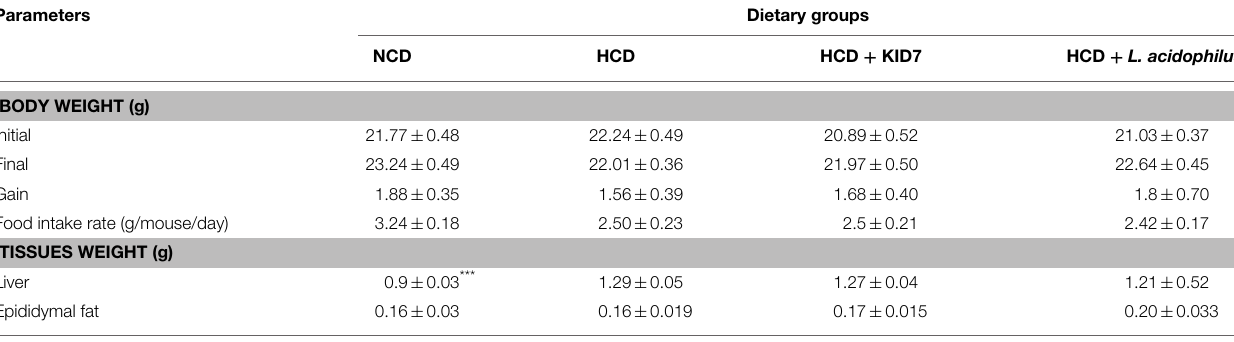
TABLE 4 | Effects of KID7 and L. acidophilus on body weight, food intake, and tissues weight in mice. Parameters Dietary groups NCD HCD HCD + KID7 HCD + L.